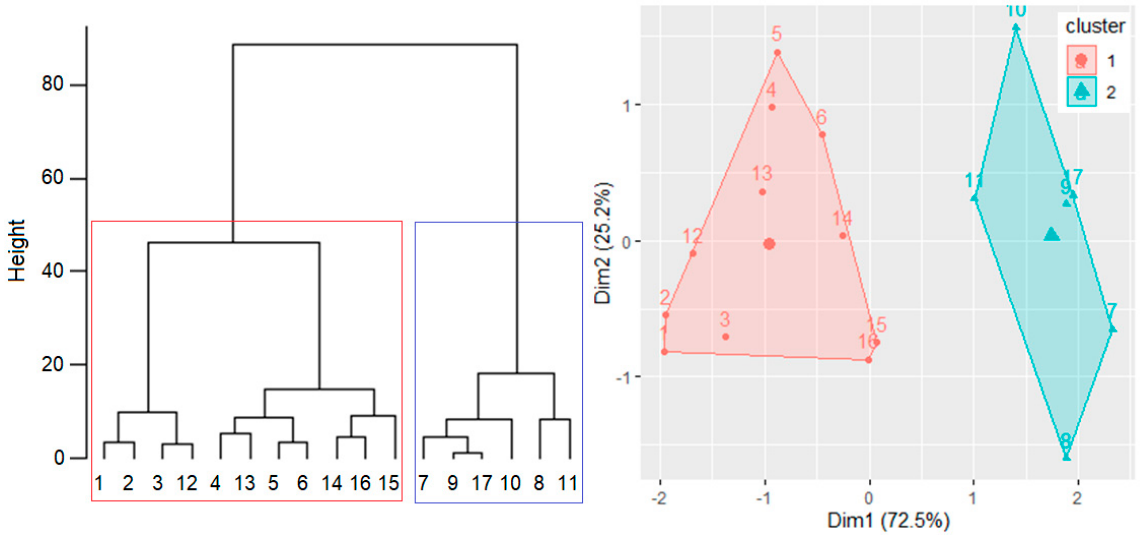
Figure 7. Dendrogram and clusters built using the yearly WQIs.